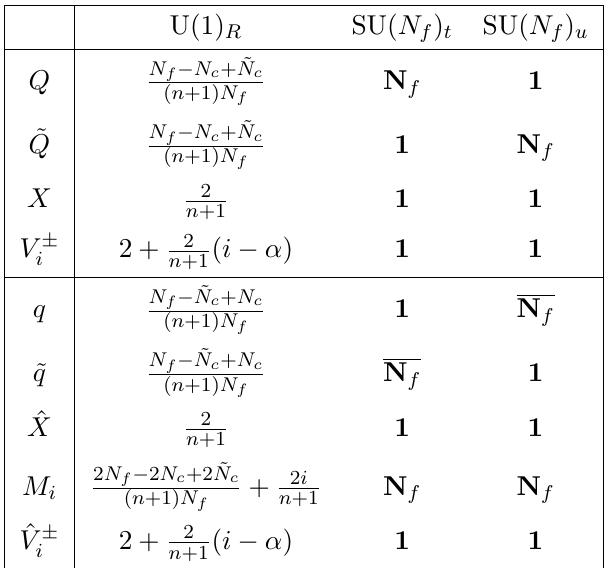
Table 2 . The representations of the chiral operators under the global symmetry groups of the single adjoint theory with the linear monopole superpotential ∆ W = V + + V − and its dual. Now the A α α monopole operators V ± and ˆ V ± are presented together with the elementary fields in the upper i i box and the lower box, respectively. Note that ˜ N is the dual gauge rank, which is now defined by c ˜ N c = nN f − N c − 2 n + 2 α